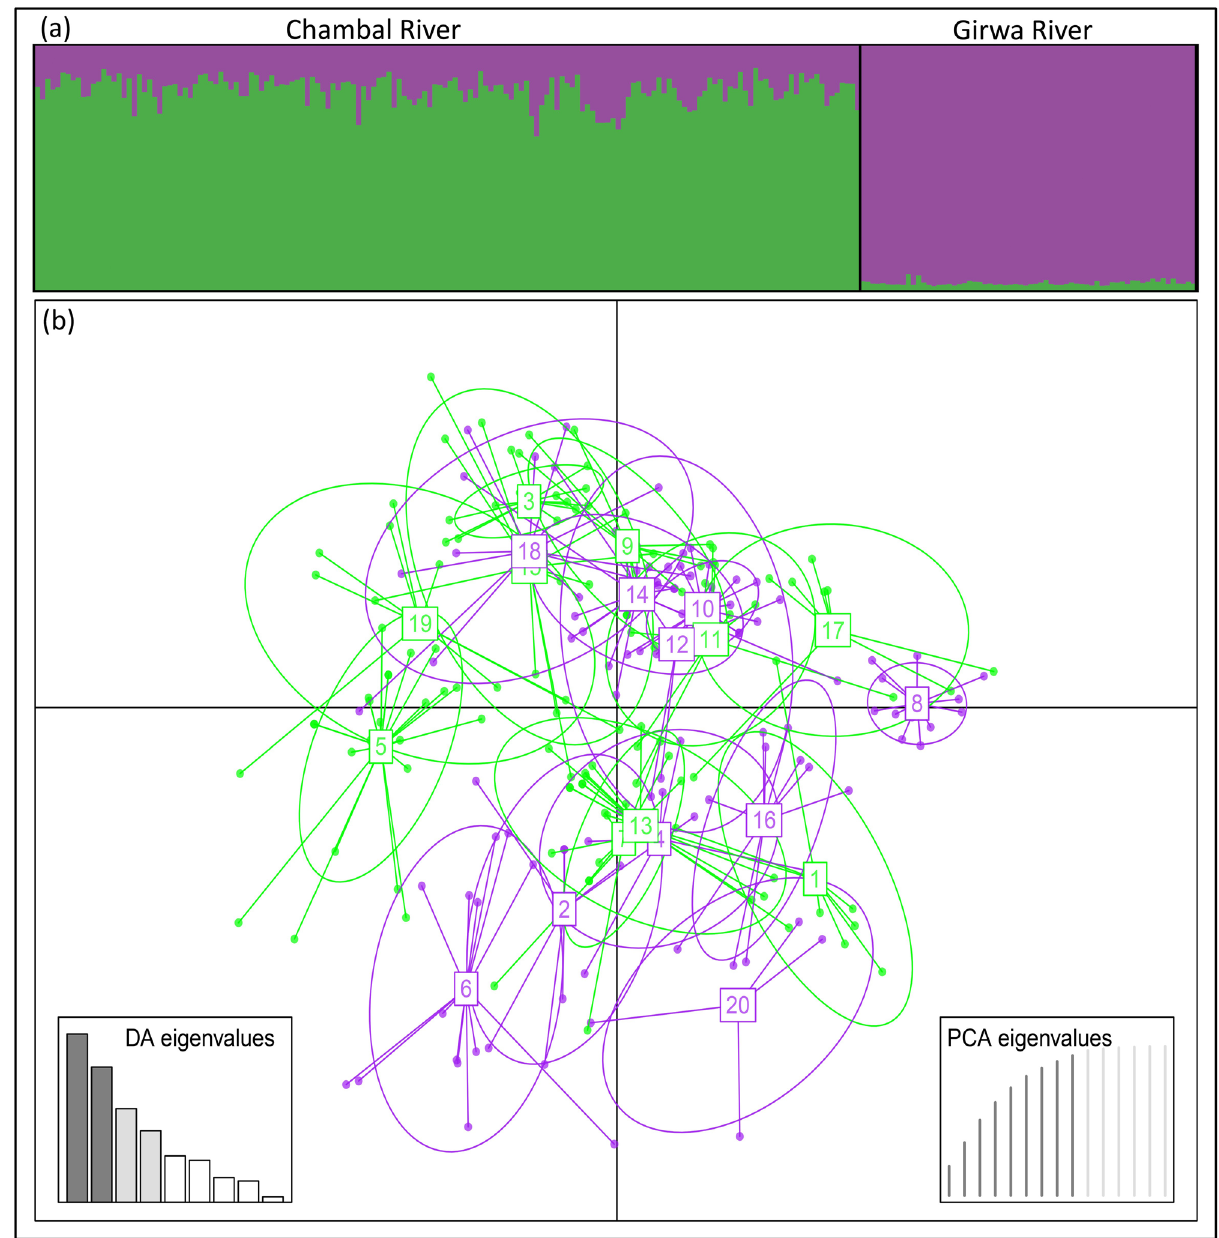
in each bar indicates the probability of assigning the individual to a particular cluster. ( b ) Scatterplot of the Discriminant Analysis of Principal Components (DAPC) of 228 gharial individuals. This scatterplot shows the first two principal components of the